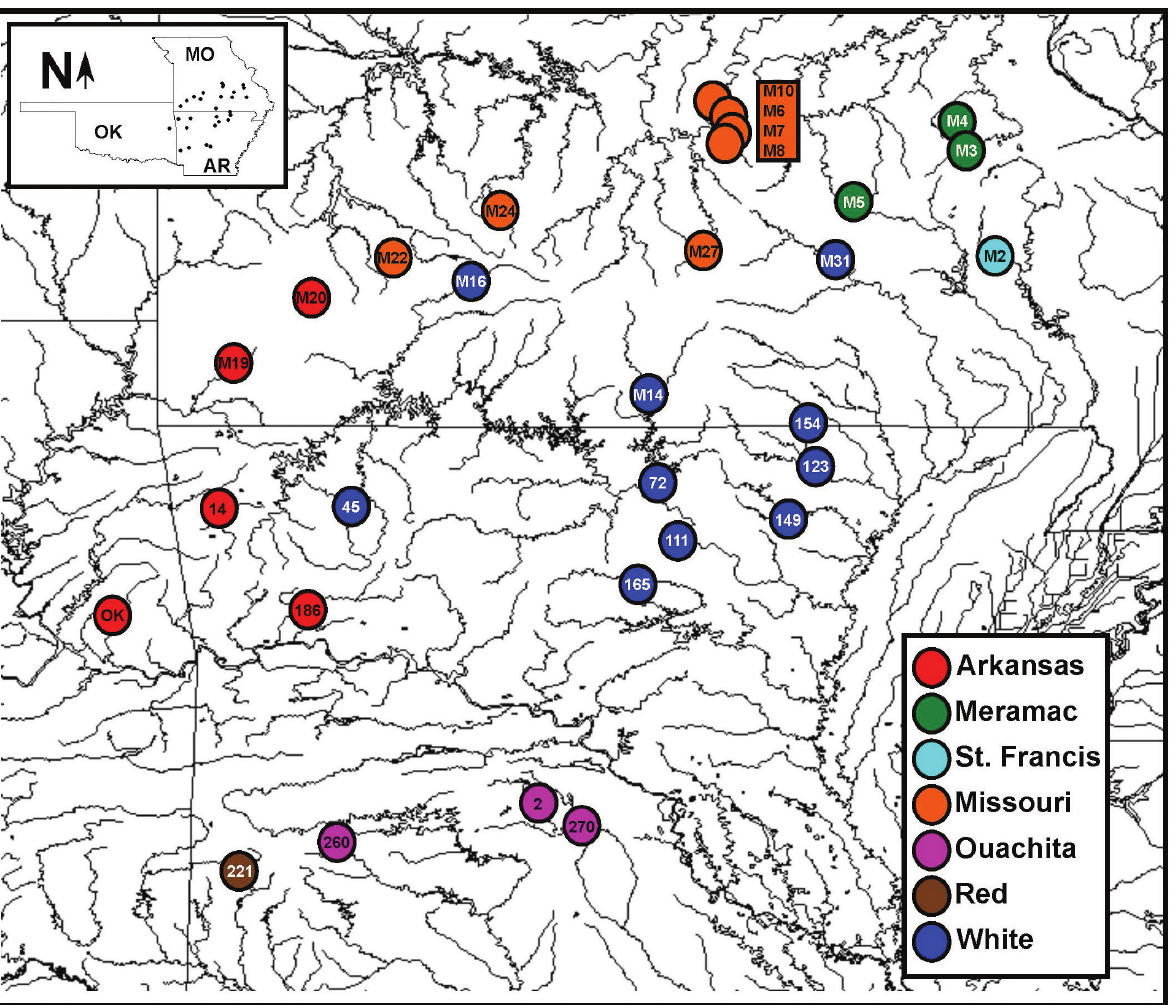
Figure 1. Map of E. potosiensis collection localities, color coded by river drainage, used in the phylogenetic analysis. Detailed locality information is in Table